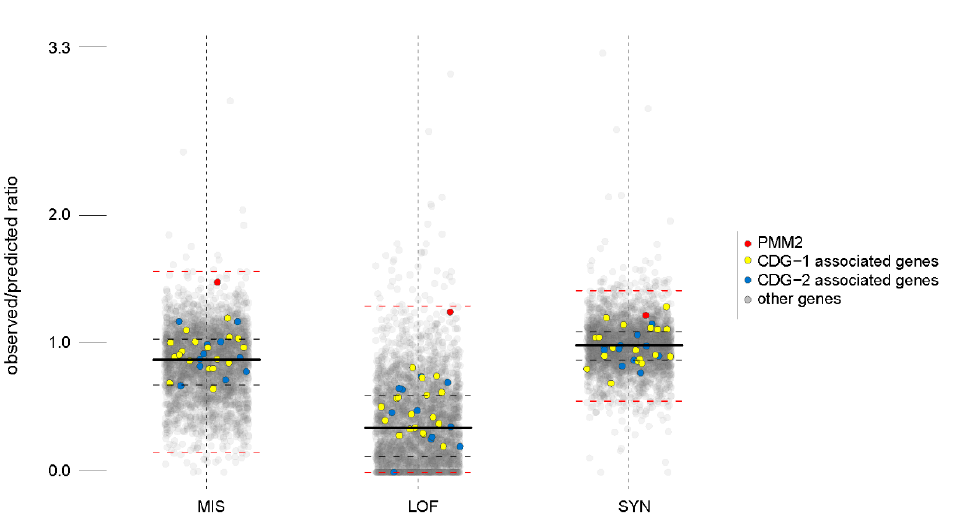
Figure 2. Observed versus expected variants for disease genes. Box-plots are drawn for the ratios between the number of observed and predicted variants in the general population for disease genes. Each dot represents a gene, the red dot is PMM2, yellow dots are the other genes associated with glycosylation (CDG)-I, and the blue dots are the genes associated with CDG-II. The medians are indicated by thick black lines; the lower and upper quartiles, representing observations outside the 25–75 percentile ranges, are indicated by dashed black lines; and the relative minimum and relative maximum values are indicated by dashed red lines.